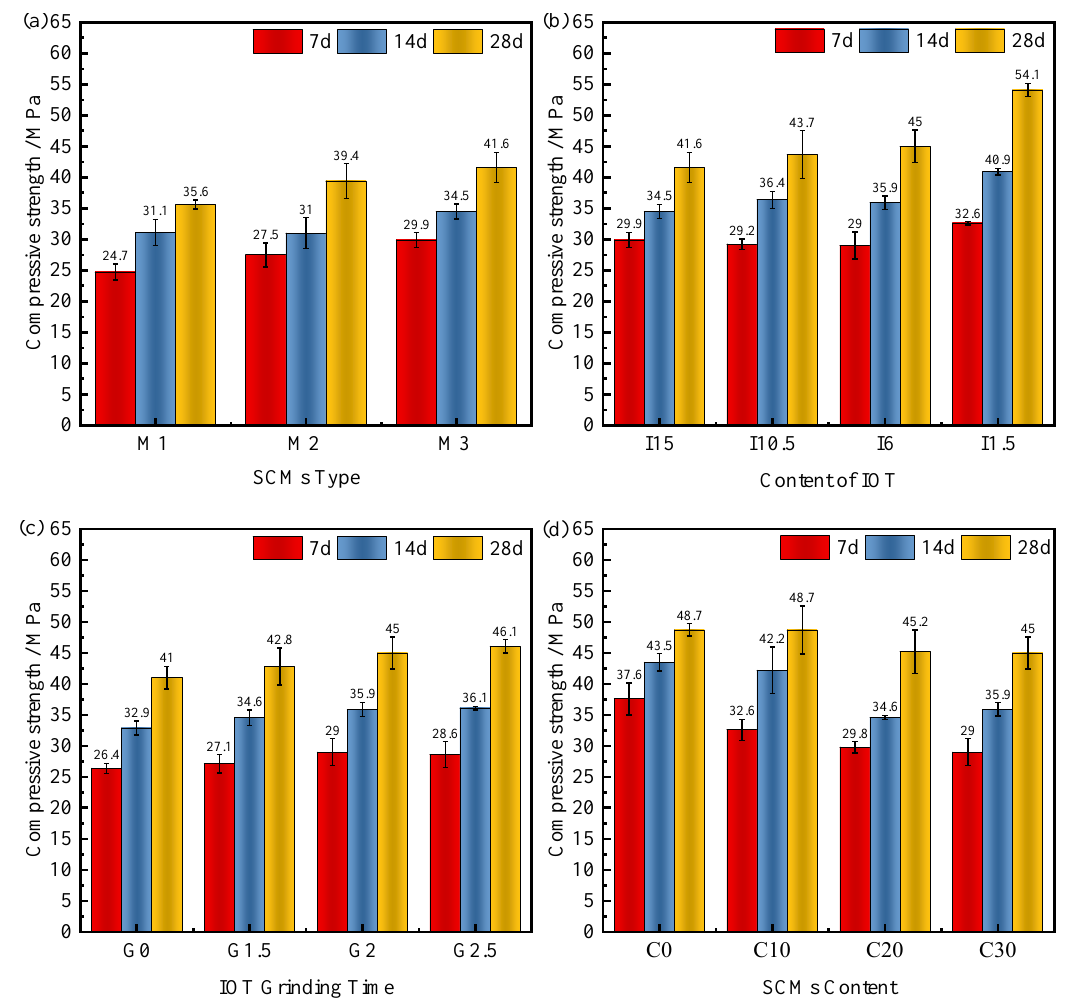
Figure 4. The influence of ( a ) SCMs Type, ( b ) Content of IOT, ( c ) IOT Grinding Time, and ( d ) SCMs Content on the compressive strength of concrete.